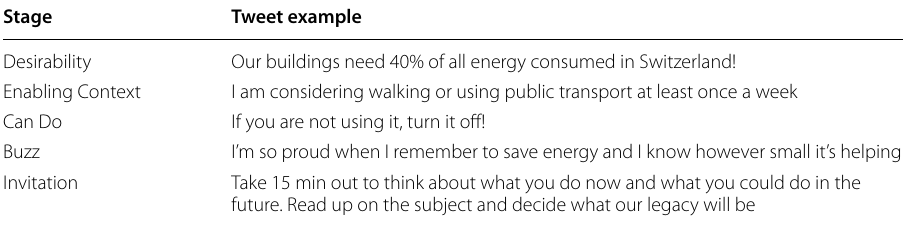
Table 1 Tweet example according to Five Doors Theory